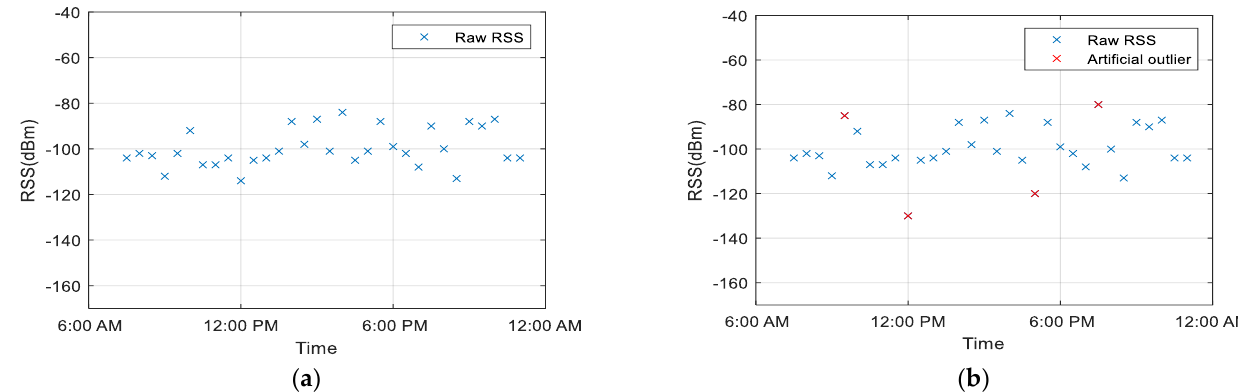
Figure 11. RSS Dataset 2 with and without the artificial outliers. ( a ) Without artificial outlier ( b ) With artificial outliers.